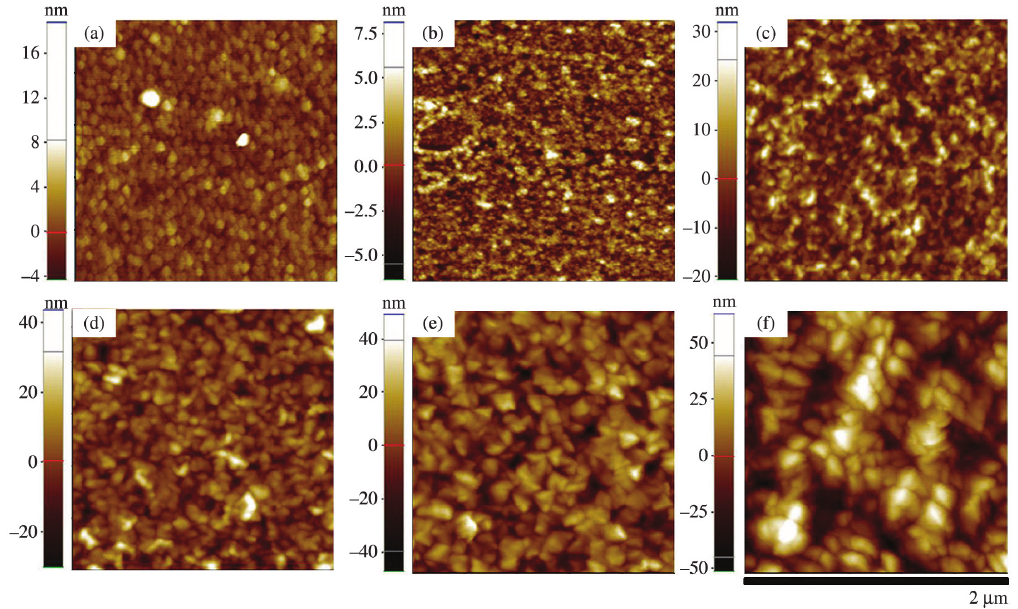
Figure 2. AFM images of glass substrate and ZnO:Al thin films grown to various thicknesses. (a) Glass substrate, (b) 25 nm, (c) 100 nm, (d) 165 nm, (e) 250 nm and (f) 465